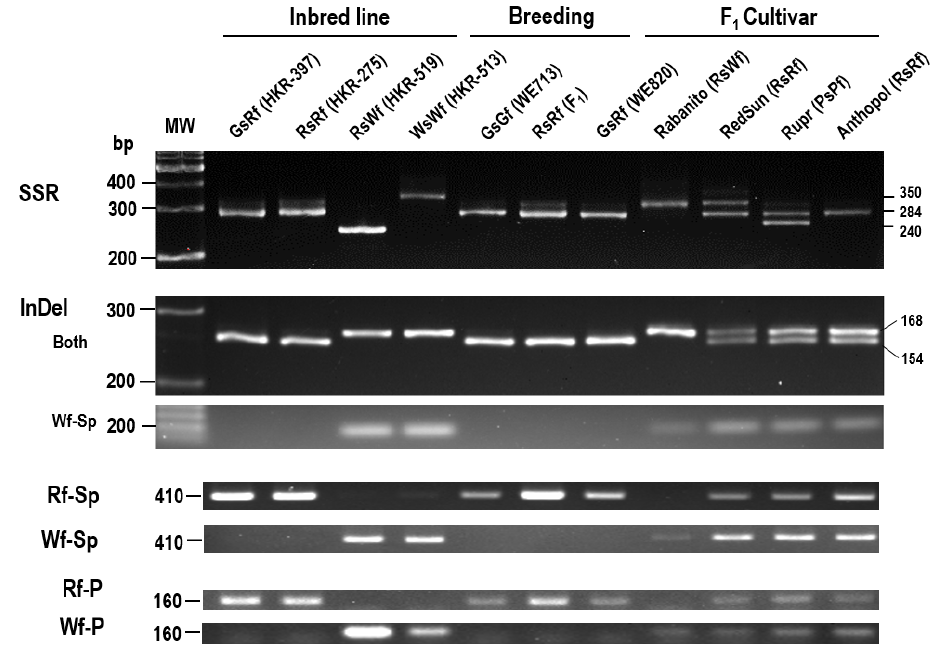
Figure 7. Development of PCR-markers derived from polymorphisms (SSR, InDel, and SNPs). (TC)- SSRs were present in the 2nd intron ranging from (TC) 13 to (TC) 68 . InDel was 14 nucleotide insertion in Wf gene and present at the 35th nucleotide of ATG upstream. Rf-Sp and Wf-Sp indicated that Rf-specific and Wf-specific amplification, respectively, which was designed using CAT InDel in 5th intron and SNP in exon 6. Rf-P/Wf-P indicated SNPs presented in the promoter regions between − 979 to − 818 nucleotide from ATG start codon. Primer sequences were listed in Table S1. Numbers on the right denoted size of band